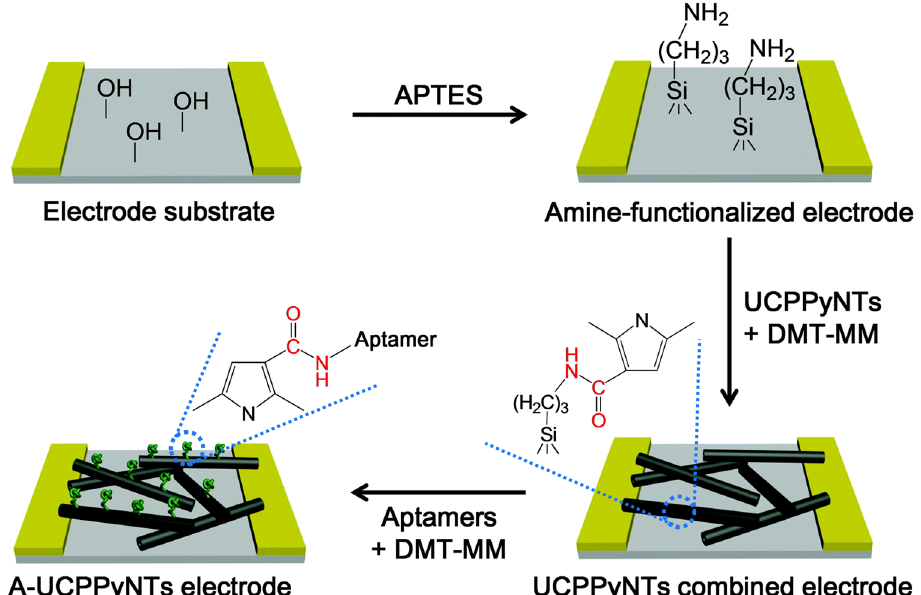
Figure 9. Schematic diagram of the binding process used to produce the biosensor electrode based on A-UCPPyNTs on the IDA electrode substrate [198]. Copyright 2016 Journal of Materials Chemistry B.